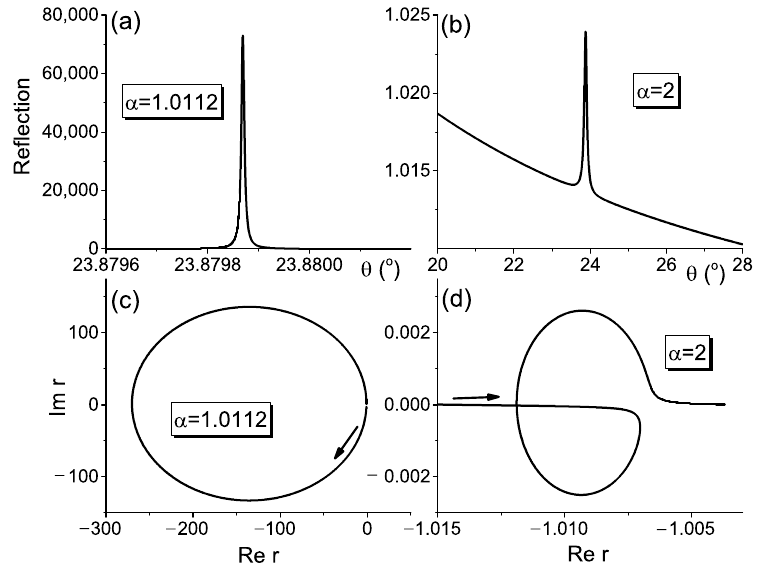
Figure 4. ( a , b ) Dependence of reflection on the incidence angle for the asymmetry parameters α = 1.0112 and 2, respectively. ( c , d ) The corresponding loops of reflection coefficient in the complex frequency plane. The arrows show the direction of the encircling. The frequency is ω = ω p , the non- Hermiticity parameter is γ = 10 − 3